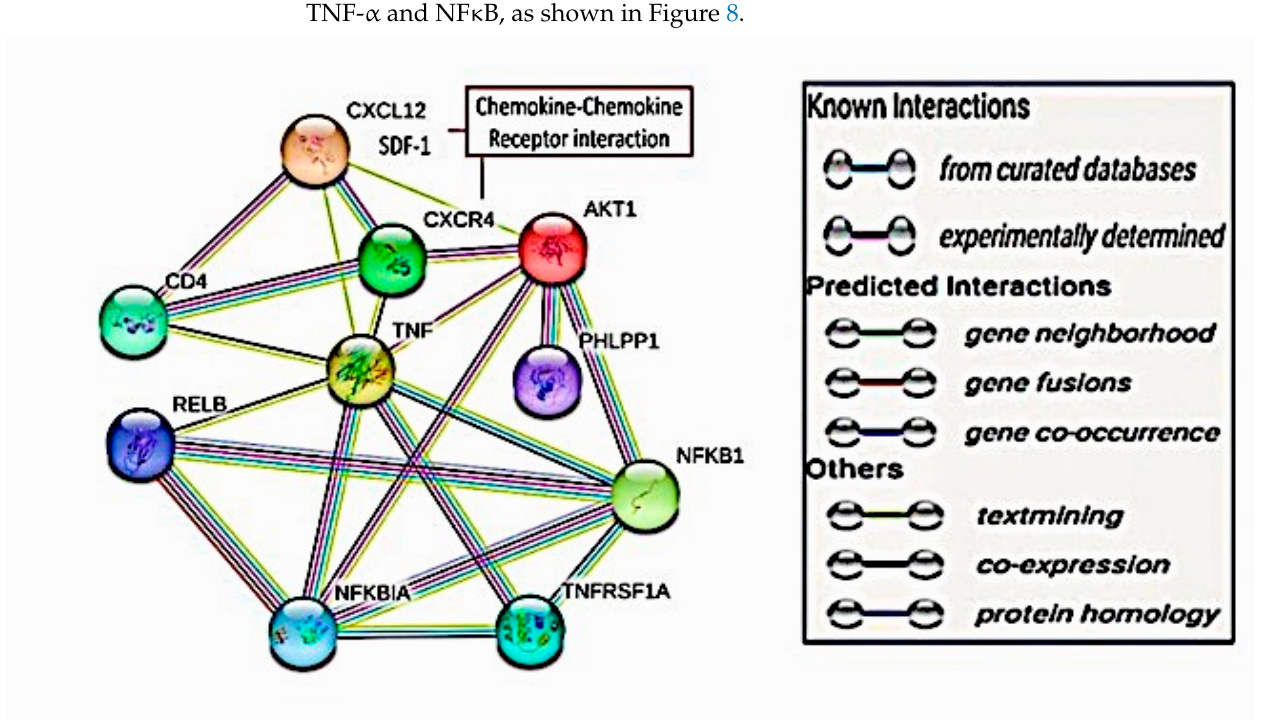
Figure 7. The computational interaction analysis of the target translational proteins related to the chemokine–chemokine receptor interactions. The STRING database was used. The confidence score was 0.700. Network edges showed the evidence interaction types. AKT, protein kinase B; CD4, T ‐ cell surface glycoprotein CD4; CXCR4, C ‐ X ‐ C chemokine receptor type 4 receptor; PHLPP1, PH do ‐ main leucine ‐ rich repeat ‐ containing protein phosphatase 1; NF κ B; nuclear factor kappa B; NFKBIA, NF ‐ kappa ‐ B inhibitor alpha; RELB, Relb proto ‐ oncogene, NF κ B subunit; SDF1, stromal cell ‐ derived